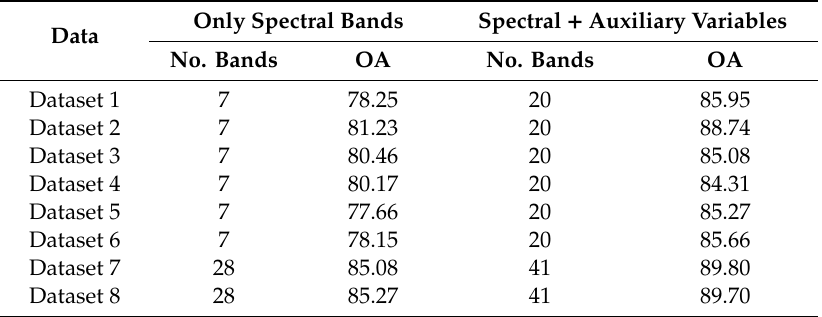
Table 2. The overall accuracy (%) from the classification results for di ff erent datasets. Only Spectral Data